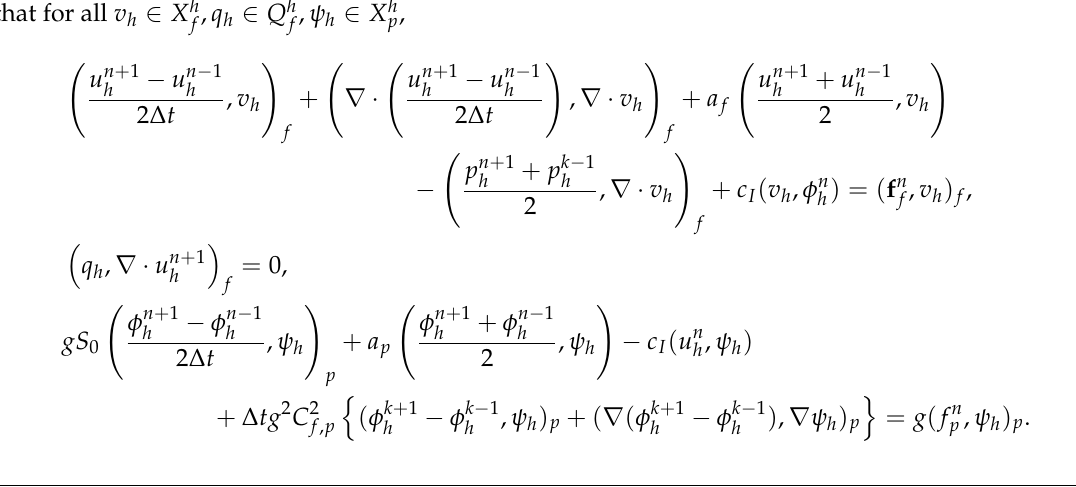
Algorithm 7 Stabilized Crank–Nicolson–Leap Frog (CNLFstab) Given ( u n − 1